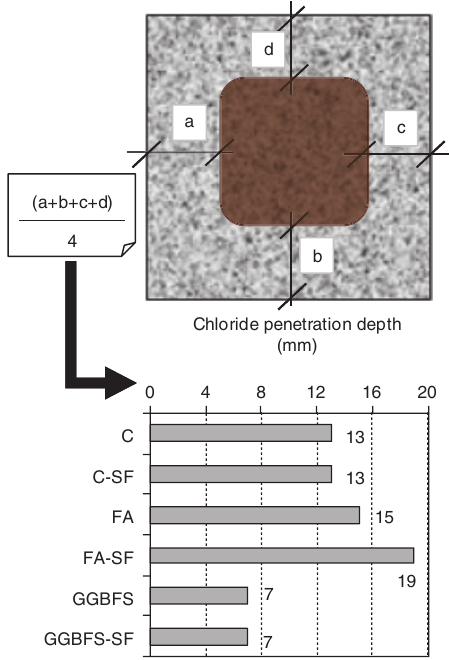
Figure 13 Chloride penetration depths.